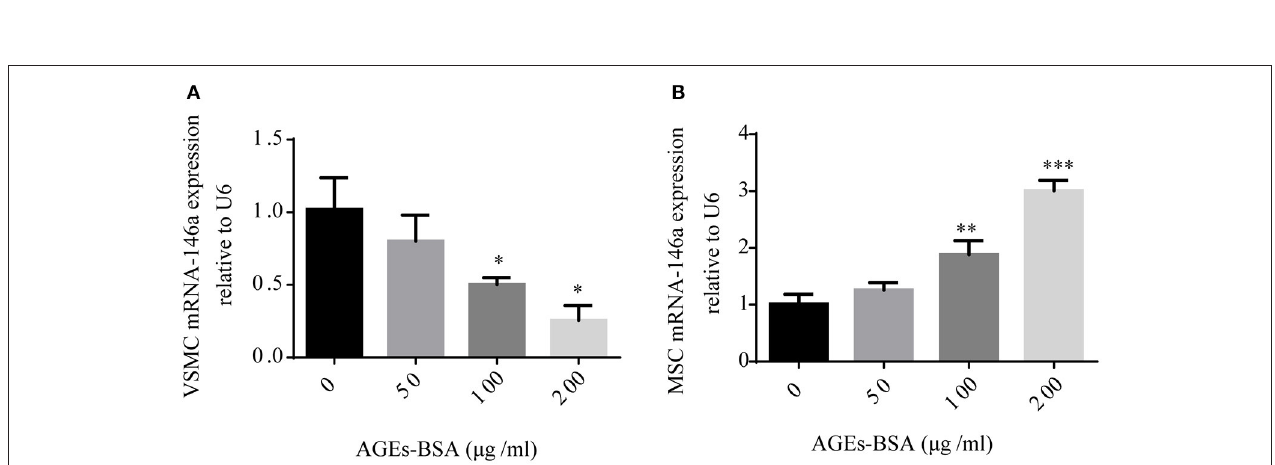
FIGURE 3 | AGEs-BSA modulates miR-146a expression in MSCs and VMSCs. (A,B) MSCs and VSMCs were treated with 50–200 µ g/mL AGEs-BSA or with 200 µ g/mL BSA (Control) for 48h, and the miR-146a level was determined by qPCR. * p < 0.05, ** p < 0.01, and *** p < 0.001 vs. the control group (200 µ g/mL BSA).